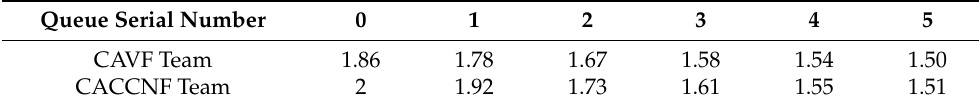
Table 3. Comparison table of HWT of CAVF fleet and CACCNF fleet over 20 s. Queue Serial Number